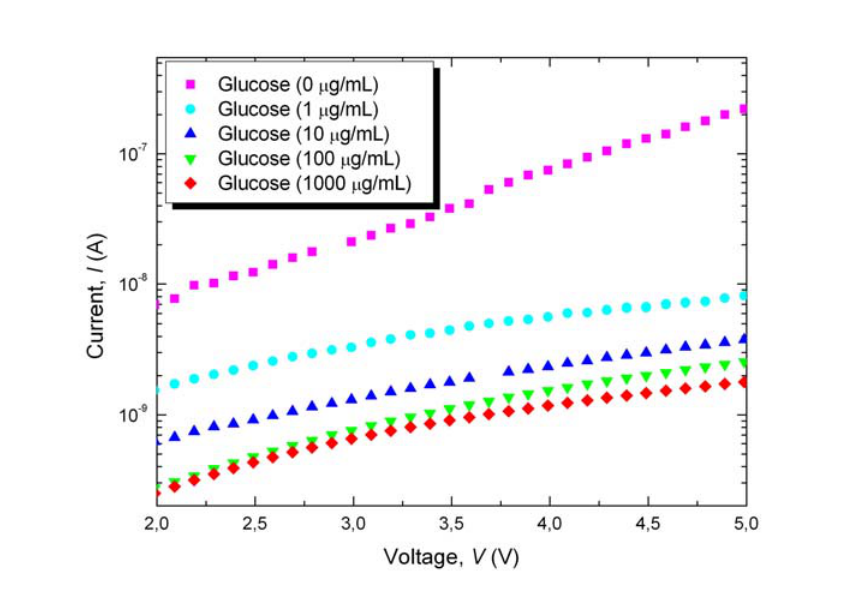
Figure 3. Current ( I ) as a function of applied voltage ( V ) for Al/nanoPS/Al structures after glucose immobilization from solutions at different